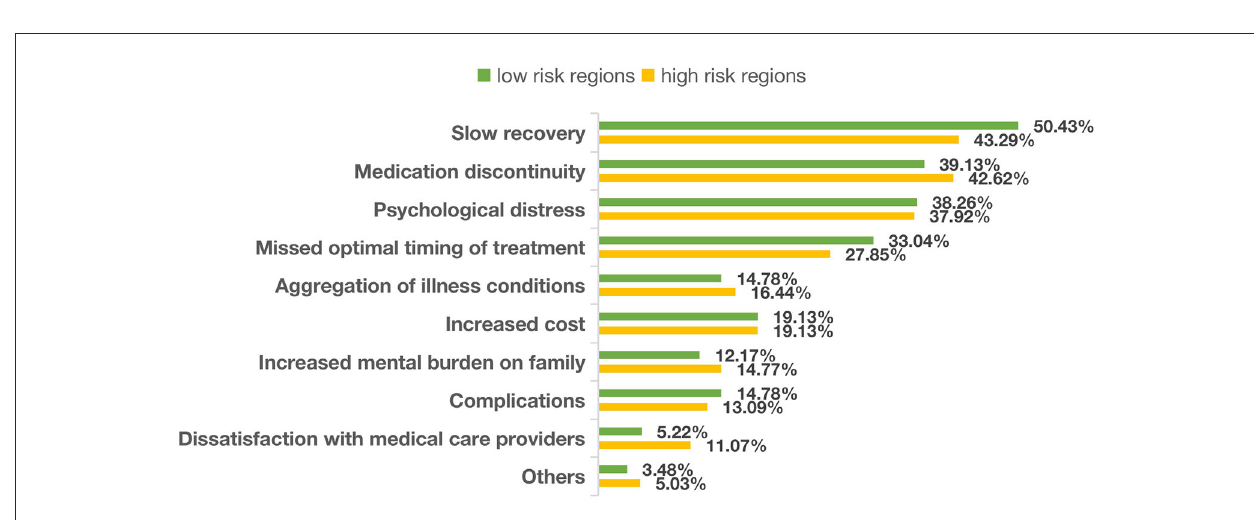
FIGURE1 Reasons of delay in seeking hospital care.